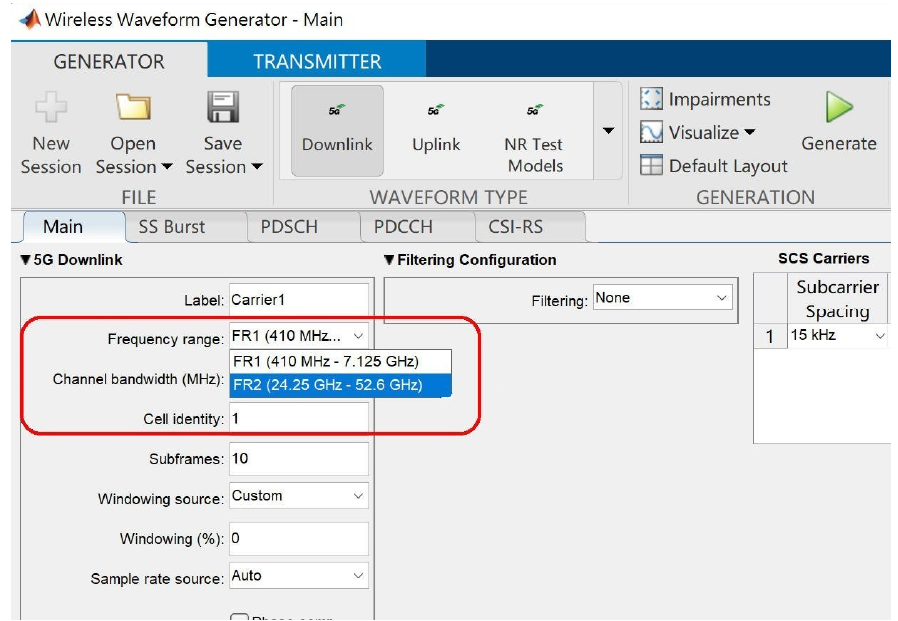
Figure A1. Setting the bandwidths of FR1 and FR2.